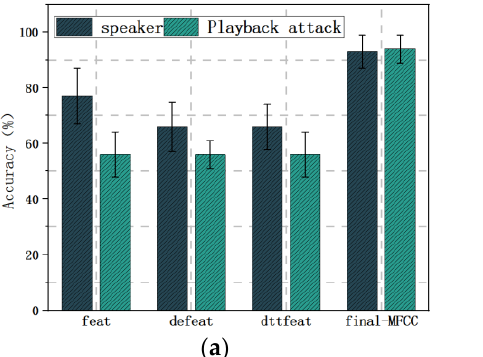
Table 2. Playback attack.